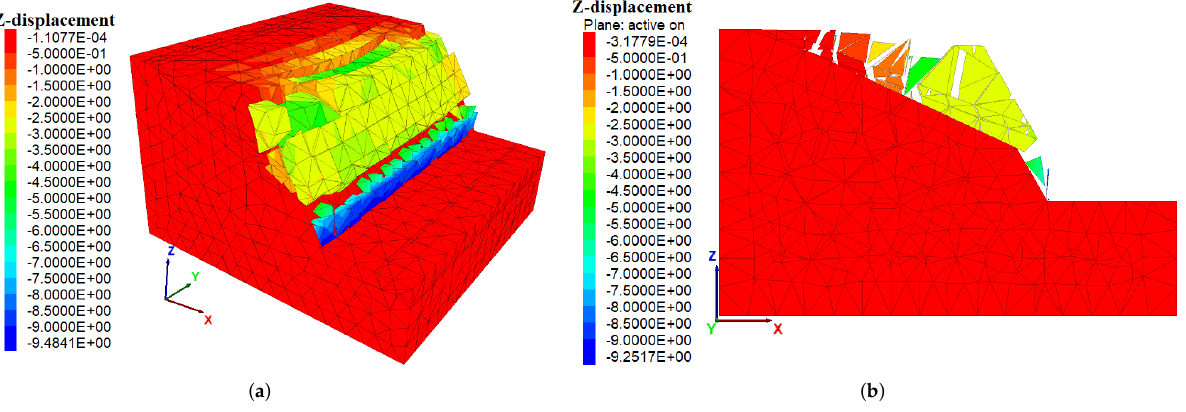
Figure 6. The Z-direction displacement when iterating to the 14,000th step. ( a ) Overview, ( b ) cross-